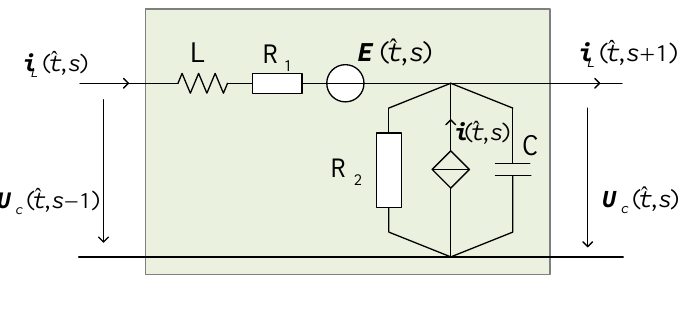
Figure 2. Ladder circuit